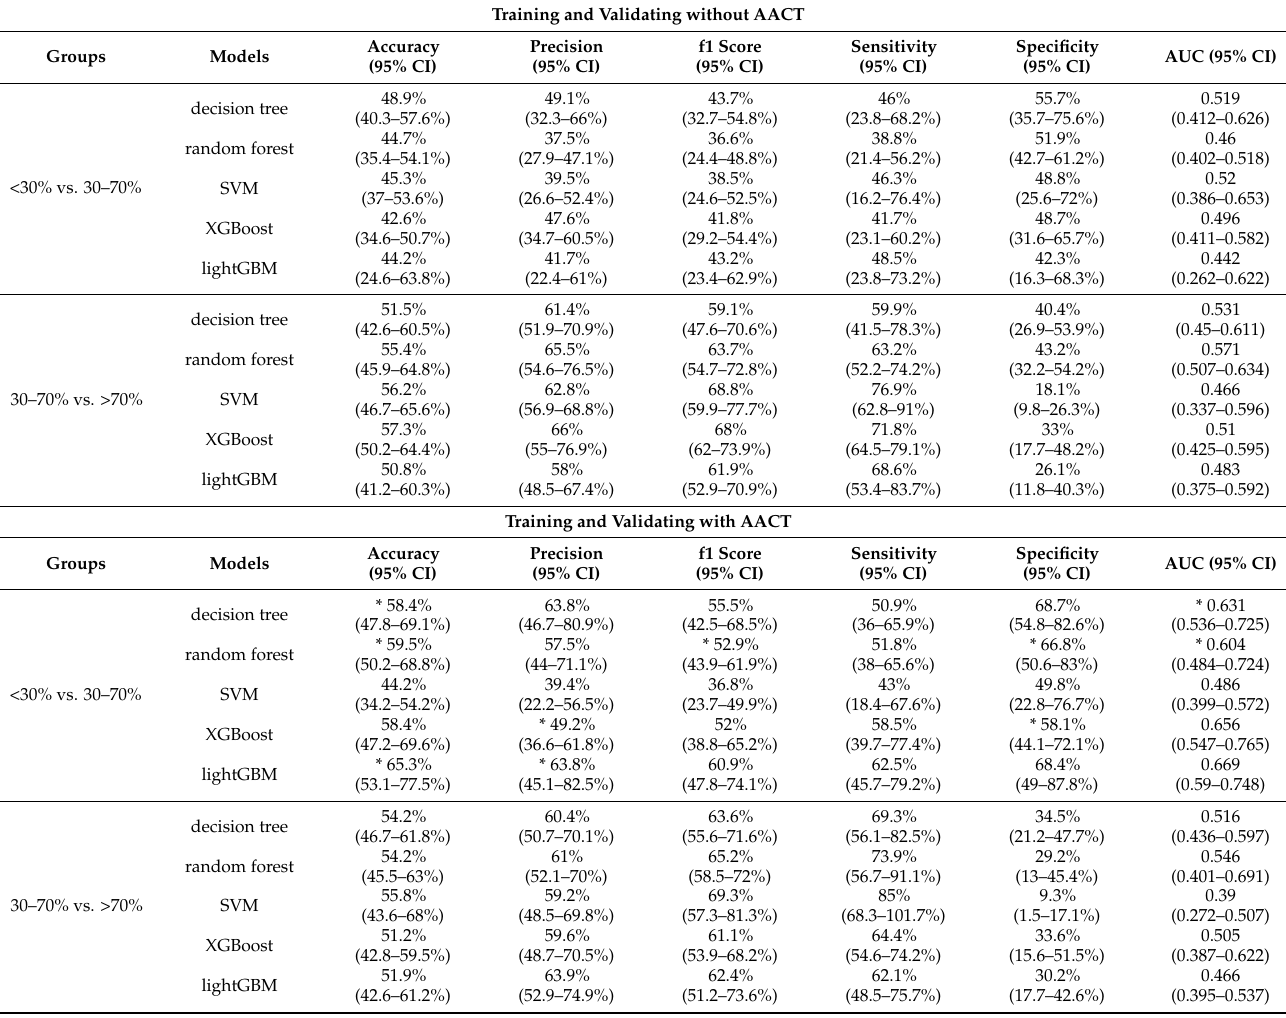
Table 4. Five machine learning models incorporated with and without